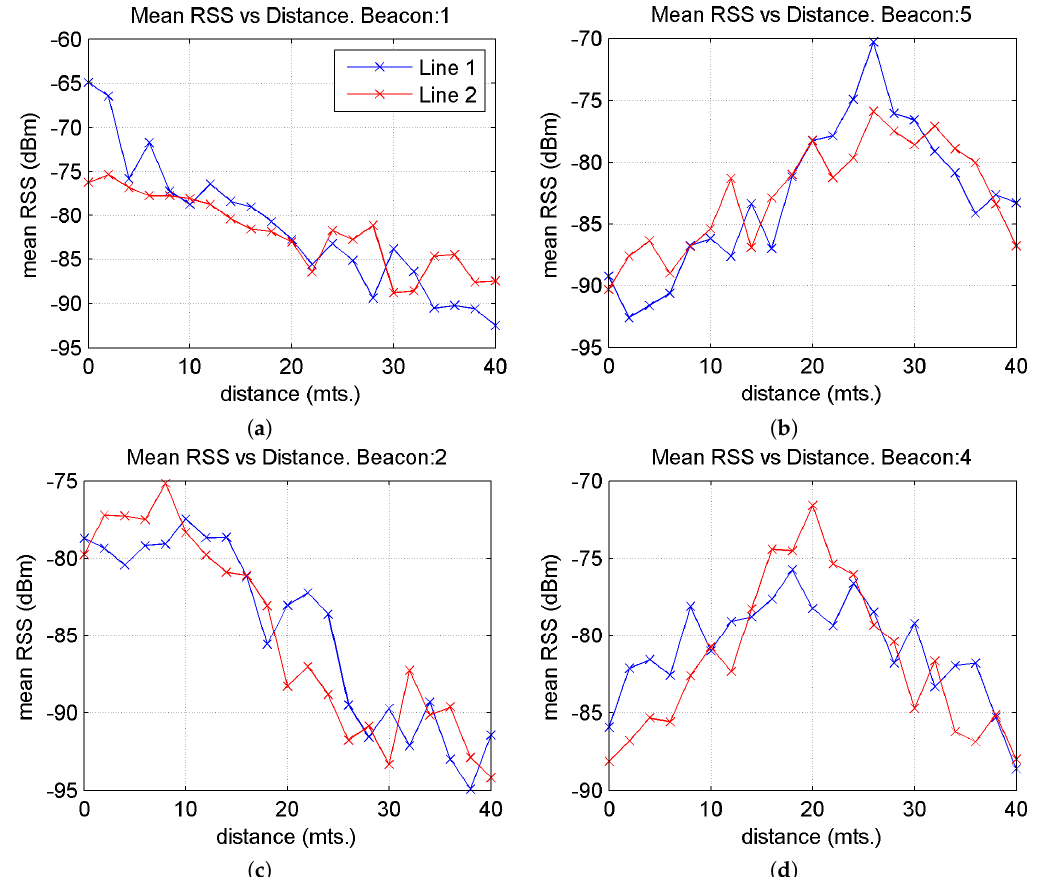
Figure 14. Graphs for the mean RSS values vs distance to the Y axis at reference points along lines 1 and 2, for 4 of the 7 beacons. ( a ) Beacons 1; ( b ) Beacons 5; ( c ) Beacons 2 and ( d ) Beacons